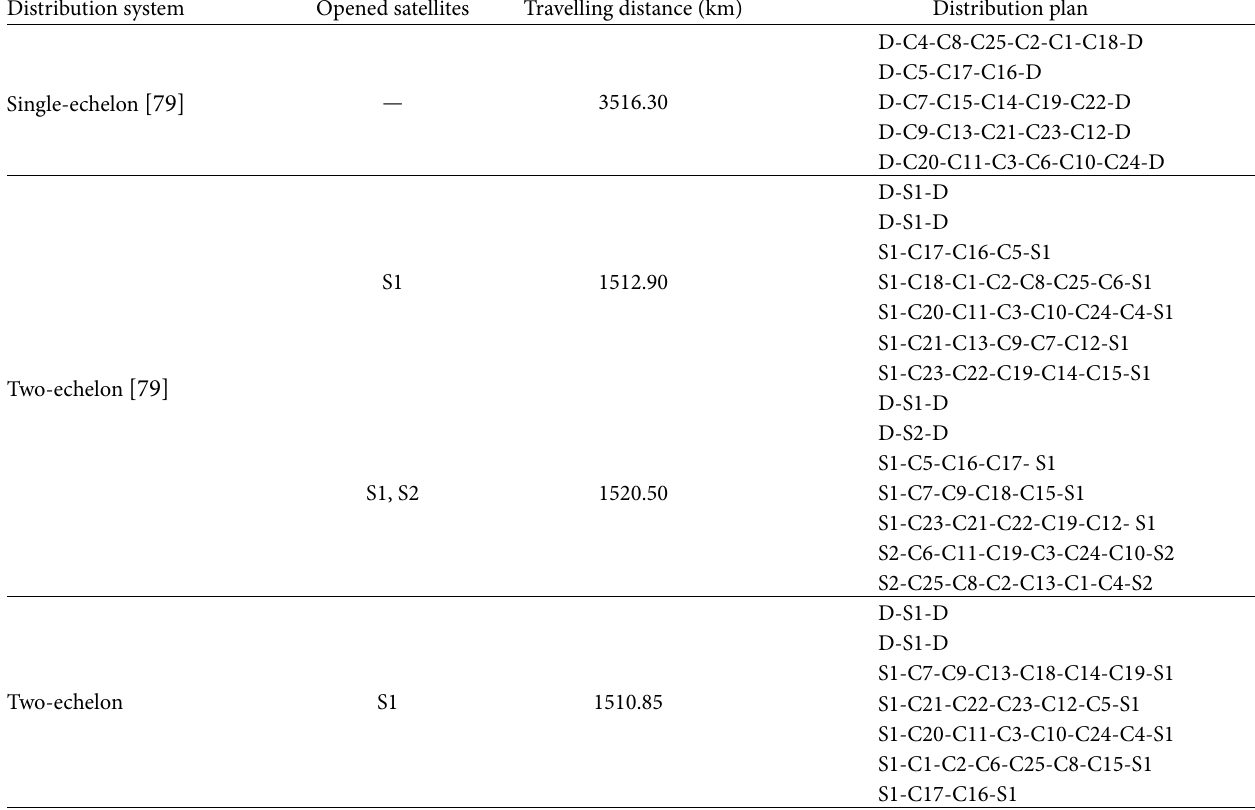
Table 7: Optimal distribution